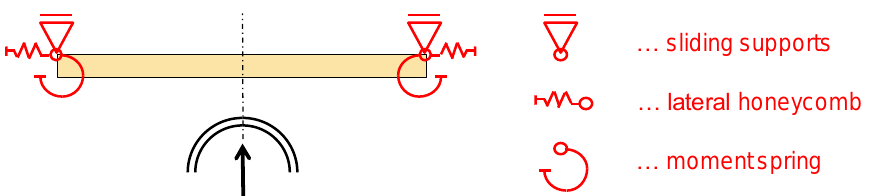
Figure 6. Static system of the wood specimen within the test bench.